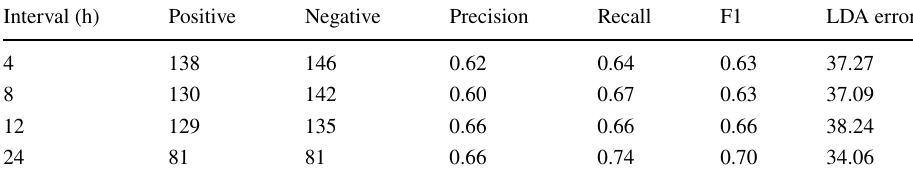
Table 3 The results: CDC criterion [3]